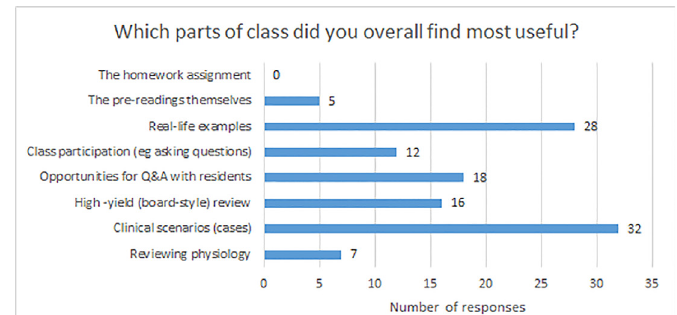
Figure 1. Responses to the question “Which parts of the class overall did you find most useful?” Q&A , question and answer.